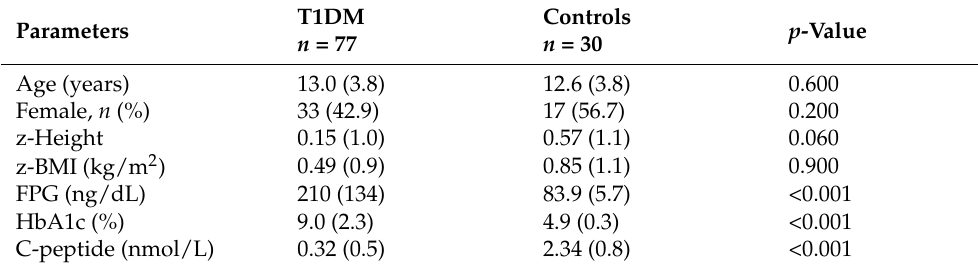
Table 1. Demographic and laboratory parameters for T1DM patients and controls.